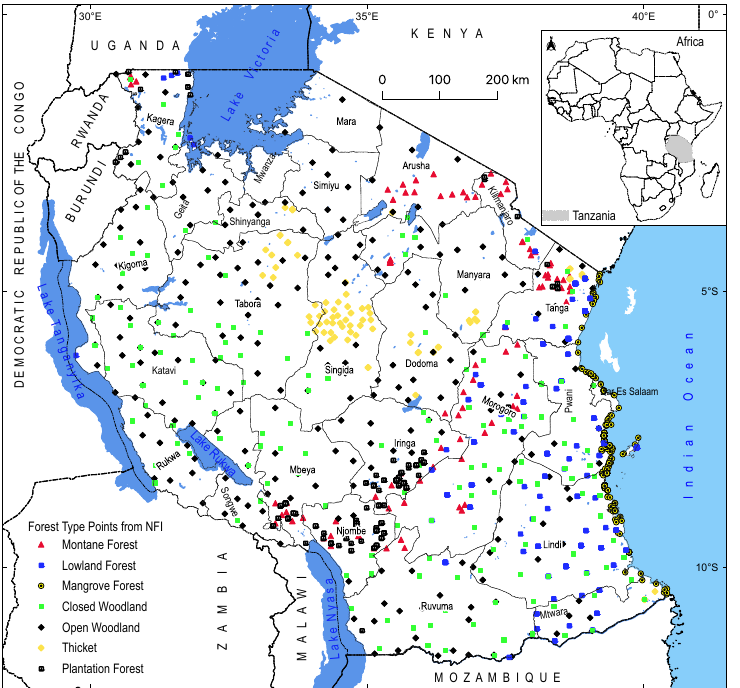
Figure 1. Map of the study area with the distribution of reference data from forest inventory samples [20] and regions